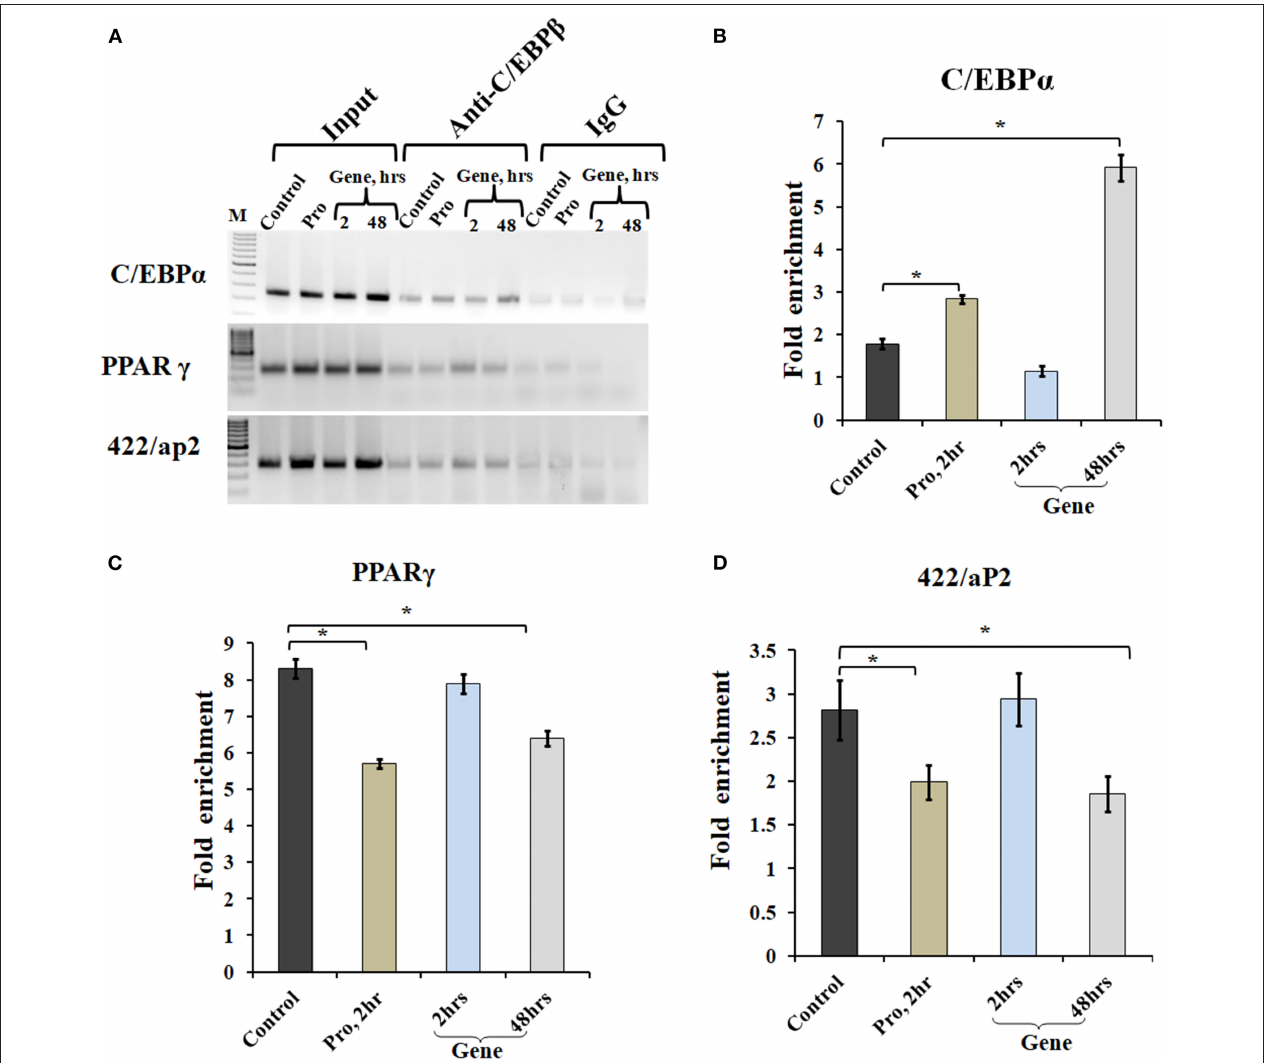
FIGURE 6 | A-C/EBP transfection affects the binding of C/EBP β to the promoter region of adipocyte marker genes. (A) Semi-quantitative PCR from ChIP samples showed binding of C/EBP β to the C/EBP regulatory element in the promoter region of C/EBP α , PPAR γ , and 422/aP2 in transfected cells. (B–D) Quantitative real-time PCR from ChIP samples of transfected cells with A-C/EBP protein and gene. Values are expressed as mean ± SD; n = 3 independent experiments. *Significantly different from the control group ( p < 0.05). Values are expressed as mean ± SD; n = 3 independent